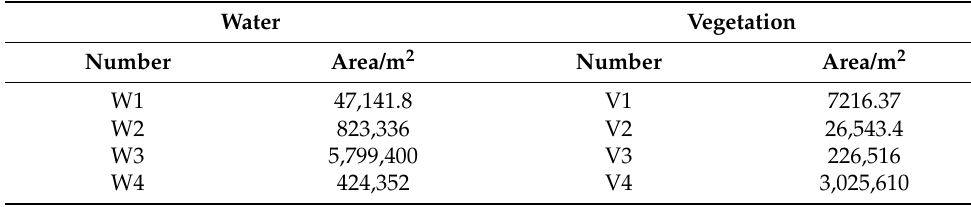
Figure 2. Land type and patch location in the study area. ( a , b ) are land types of urban underlays; ( c ) is patch location map of water and vegetation. Wi is the extracted water patch, Vi is the extracted vegetation patch. Table 1. Water and vegetation patch sample information. Table 1. Water and vegetation patch sample information. Water Vegetation Number Area/m 2 Number Water Vegetation Number Area/m 2